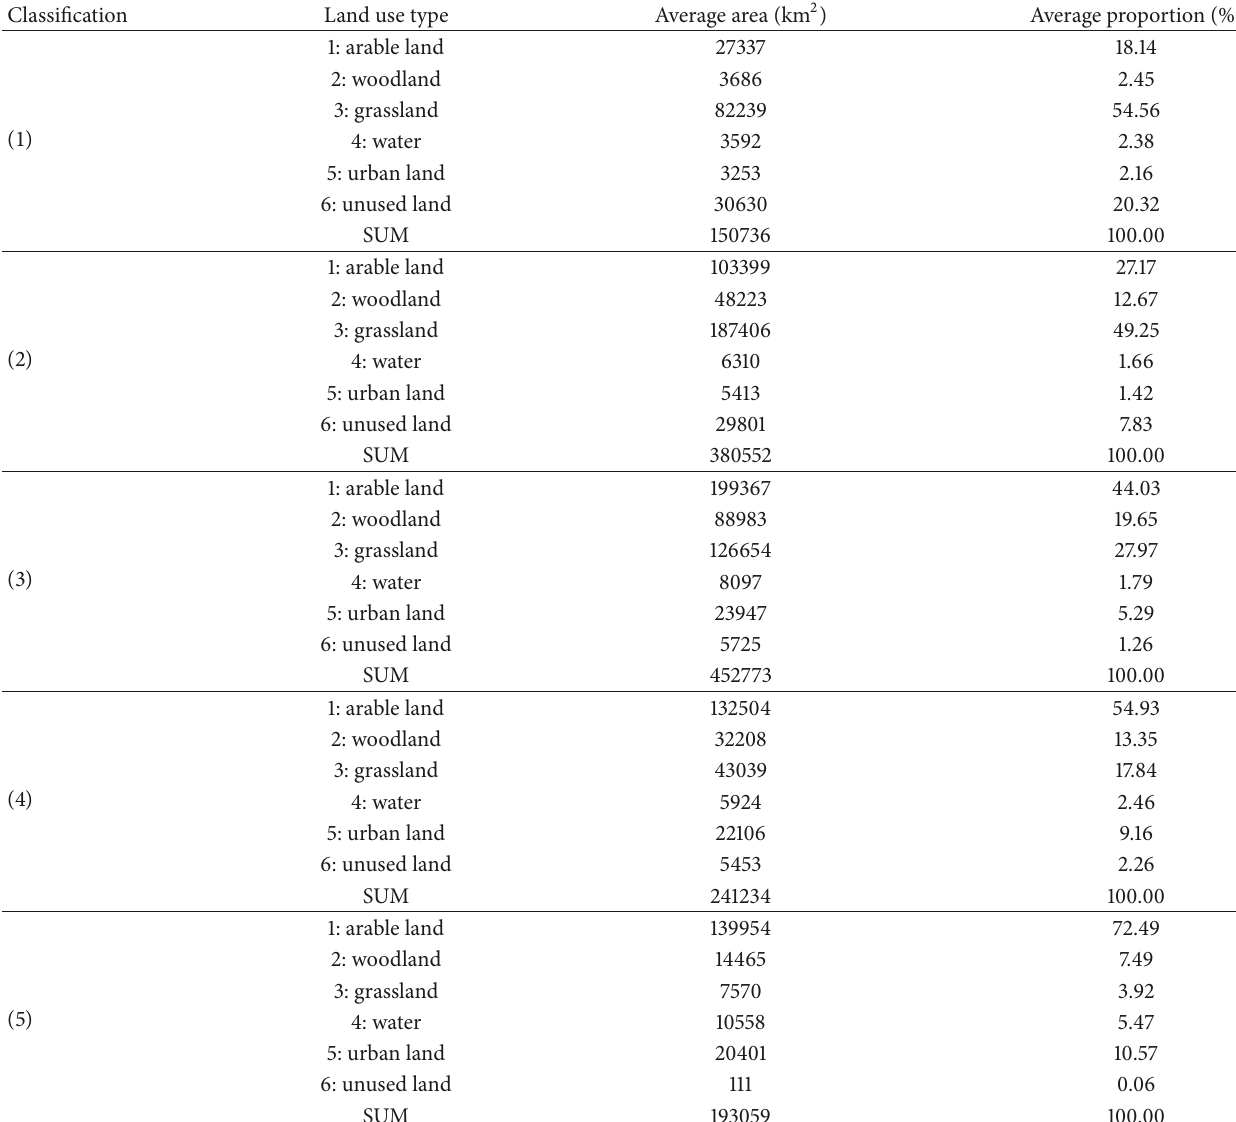
Table 2: Area of different LUC types in various type